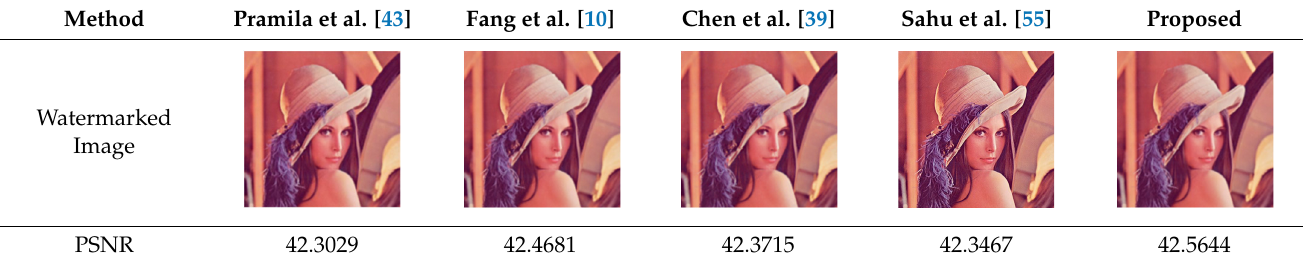
Table 3. Performance evaluation results of the proposed watermarked images against different algorithms.